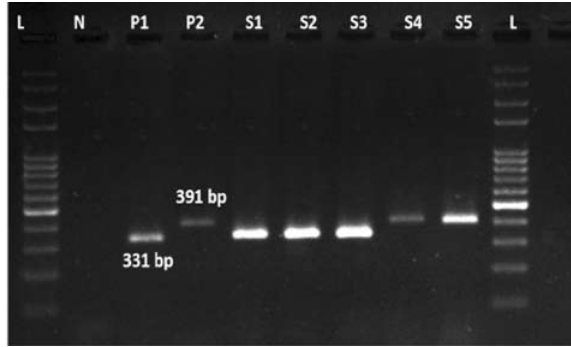
Fig. 3. Detection of lpx A gene of C. jejuni and C. coli by